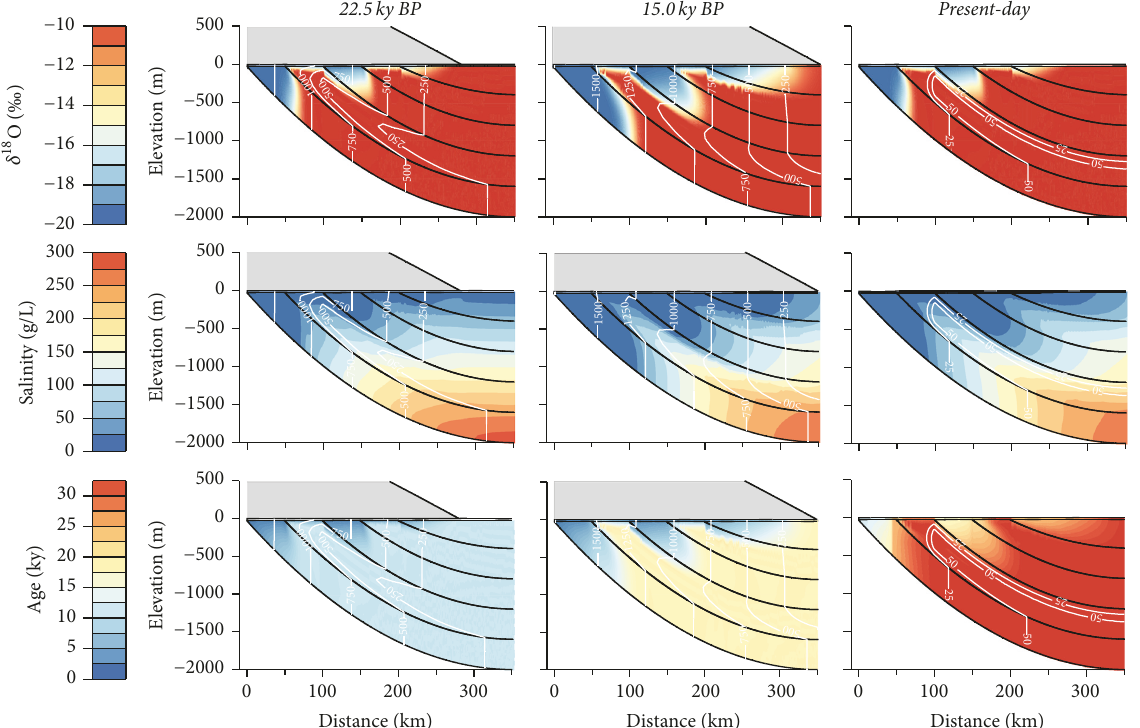
Figure 6: Evolution of hydraulic head, 𝛿 18 O, salinity, and groundwater age during reference simulation A. White lines are hydraulic head isocontours, spaced 250 m in the two first columns, 25 m in the last. Vertical exaggeration = 100.